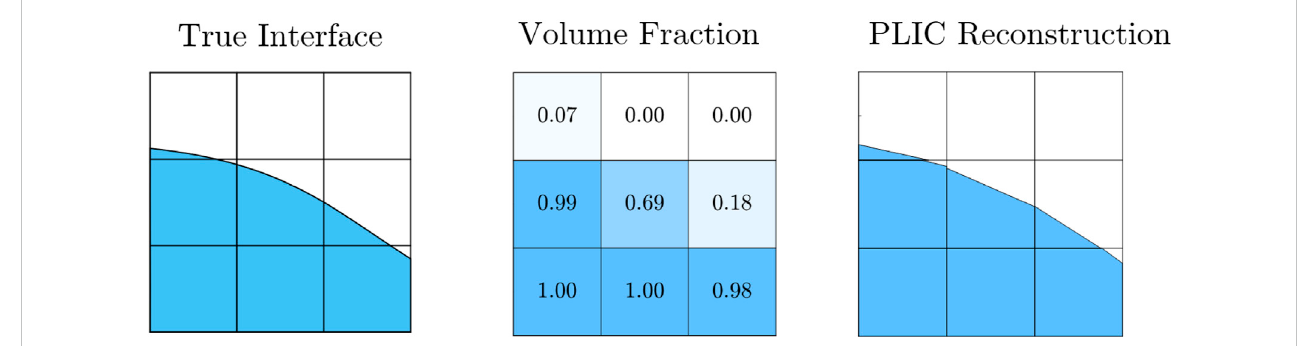
FIGURE 2 Illustration of volume-of- fl uid and planar interface construction methods. Left: Description of a true liquid – gas interface. Center: Discrete cellular representationofvolumeof fl uid,withnumbersrepresentingthefractionoccupiedbytheliquid.Right:Discreteandpiece-wiserepresentationofcontinuous interface showing planar distribution of fl uid